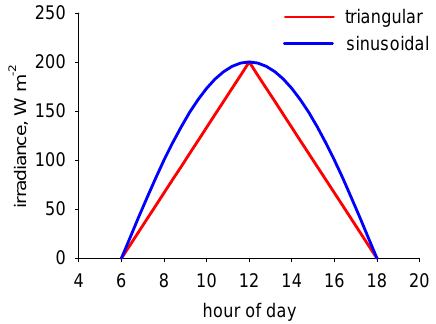
Figure 5. Photosynthesis–irradiance curves with parameter set- = 2.5gC (gchl) − 1 h − 1 and α = 0.15gC (gchl) − 1 h − 1 tings V max P (Wm − 2 ) − 1 ; Smith function (Eq. 7) and exponential function (Eq. 8).